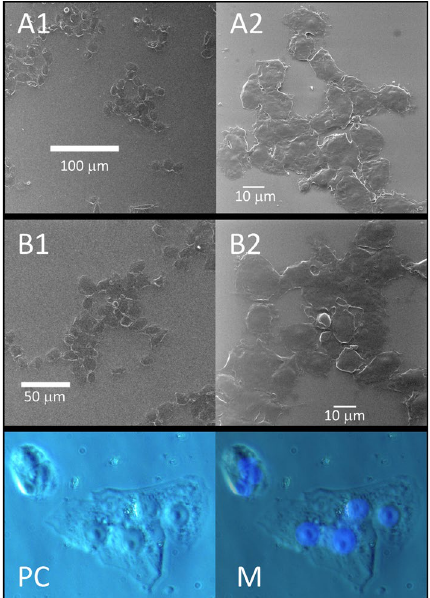
Figure 7. Fusion of SARS-CoV-2 infected host cells. Infected cells form submillimeter clusters of multiple fused cells at 24 h post-infection. HeIM highlights the continuity of their membranes, while fluorescence microscopy shows the presence of multiple DAPI stained fluorescent nuclei (blue in M) in clusters of cells imaged with phase-contrast microscopy